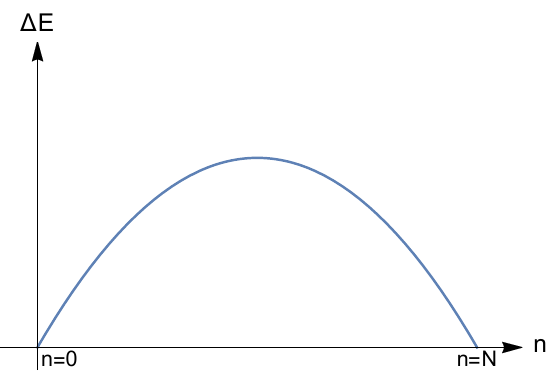
Figure 2 . A schematic plot showing the energy lift when n out of the N copies of the c = 6 CFT are excited. The lift vanishes when n = 0 and when n = N : the n = 0 state is the vacuum and the n = N state is a spectral (cid:13)ow of the